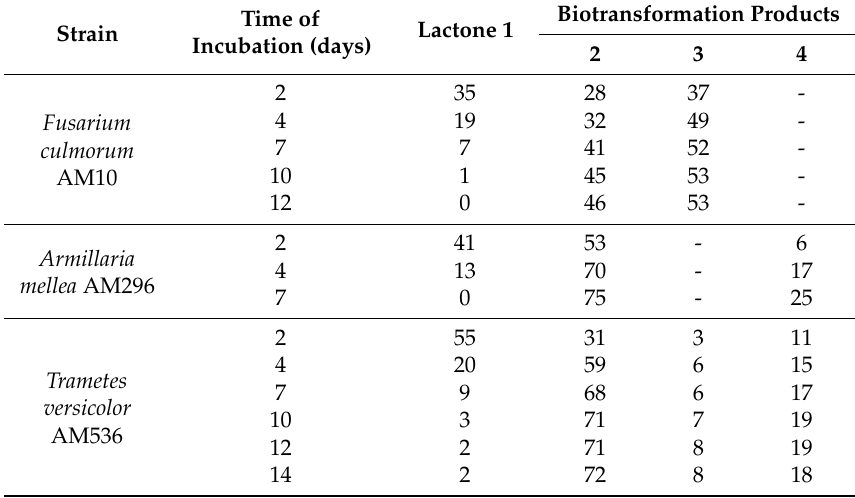
Table 1. The composition (in % according to GC) of the products’ mixtures of screening biotransformations of lactone 1